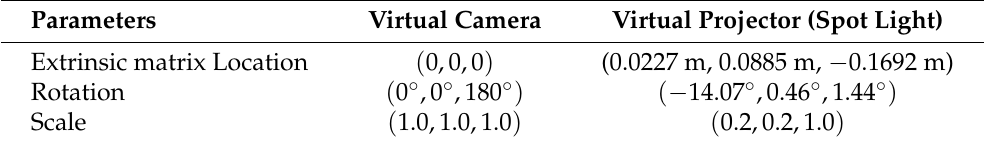
Table 1. Parameters of the virtual FPP